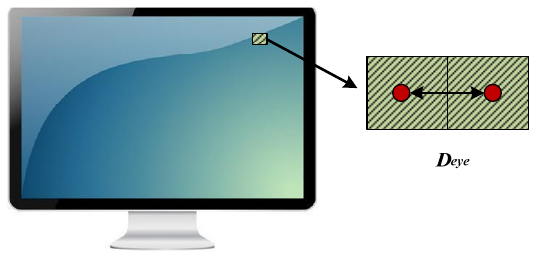
Figure 3. The minimum number of pixels that the human eye can distinguish.